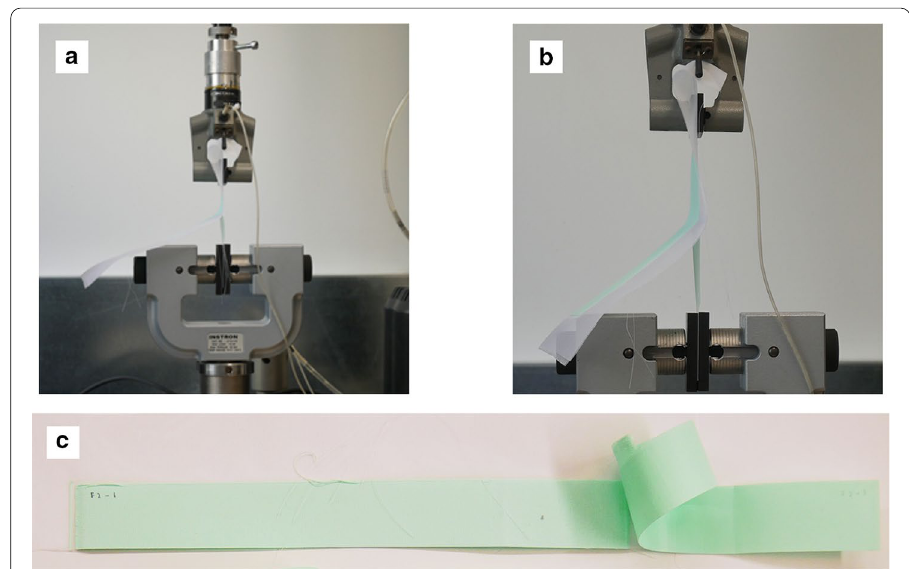
Fig. 5 a Test setup, b failure mode for the PLA—polyester (voile structure)—PLA orientation and c adhesion